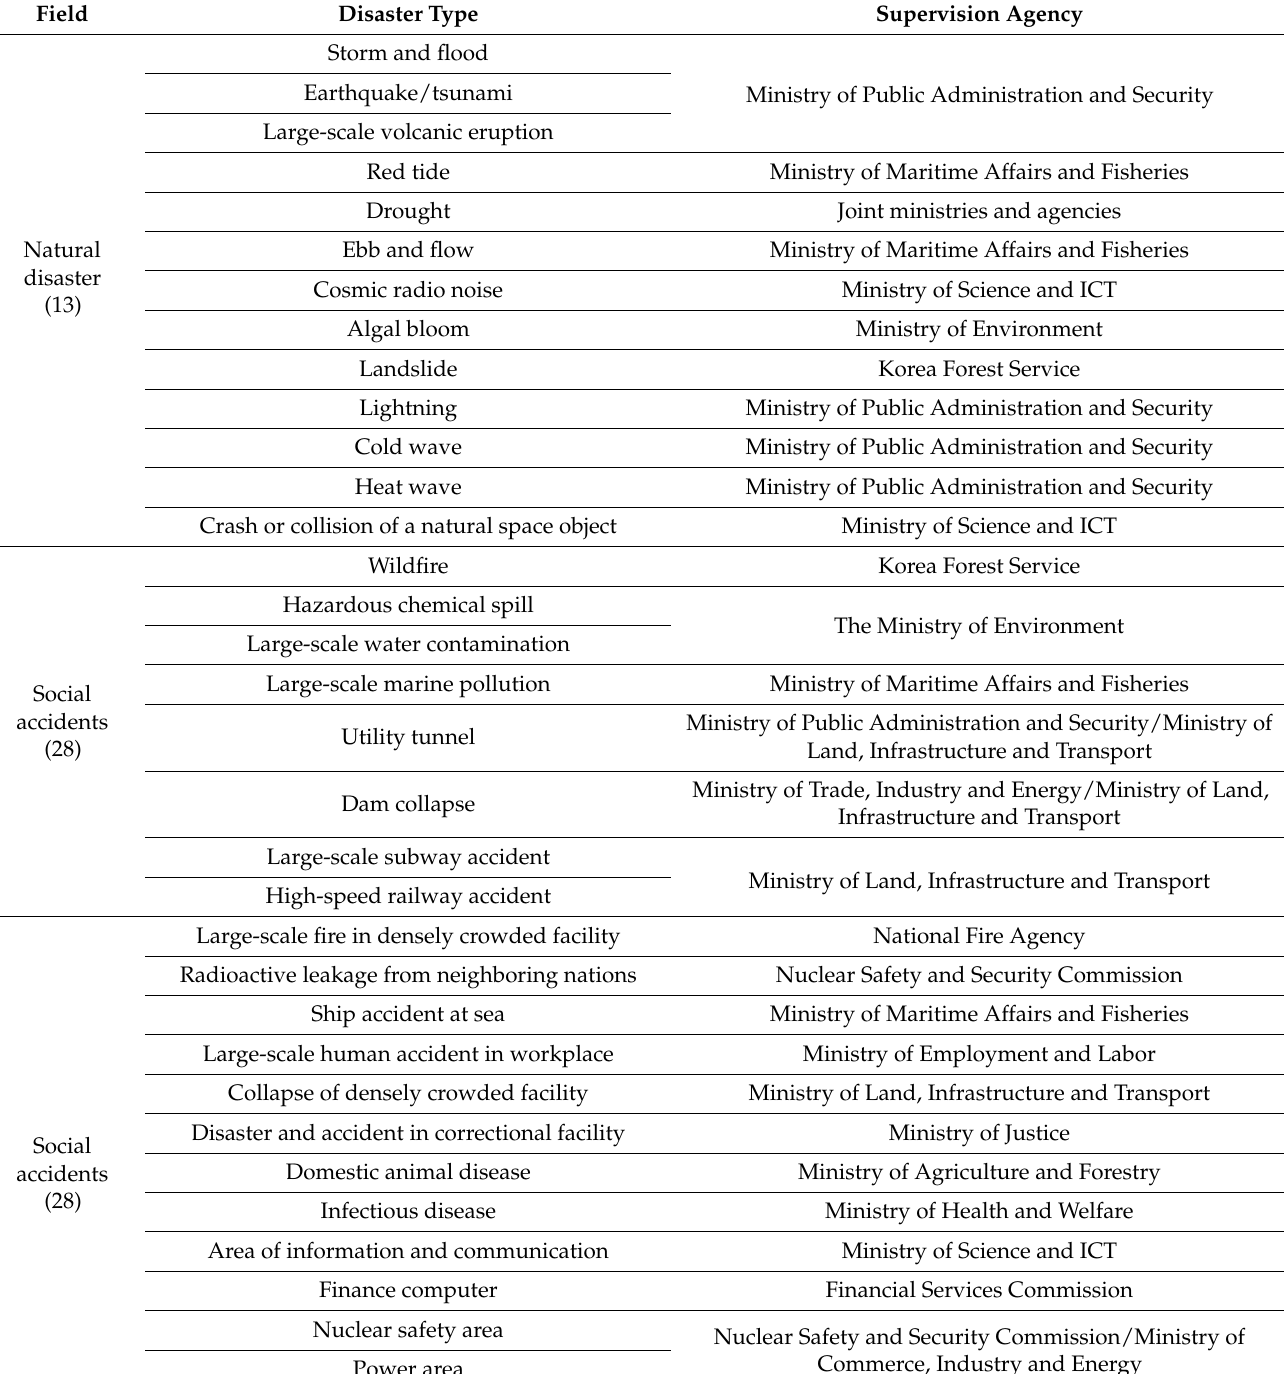
Table 2. Forty-one disaster types and supervision